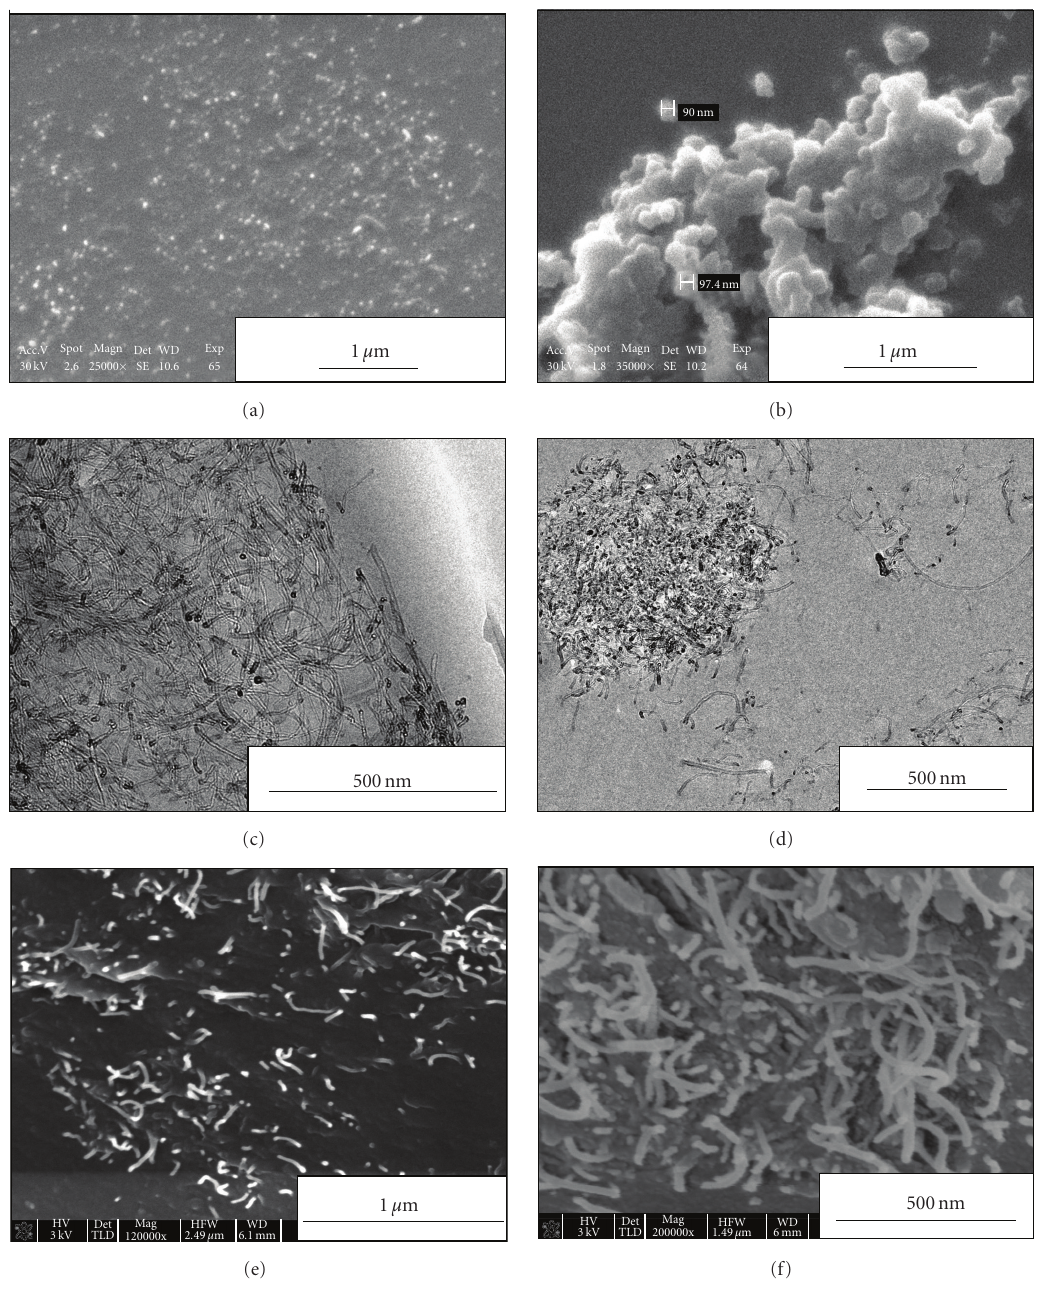
Figure 2: SEM, TEM and FEG-SEM micrographs of epoxy resin reinforced with 0.1 and 0.25 wt% CNTs: (a) SEM 0.1%, (b) SEM 0.25%, (c) TEM 0.1%, (d) TEM 0.25%, (e) FEG-SEM 0.1% and (f) FEG-SEM